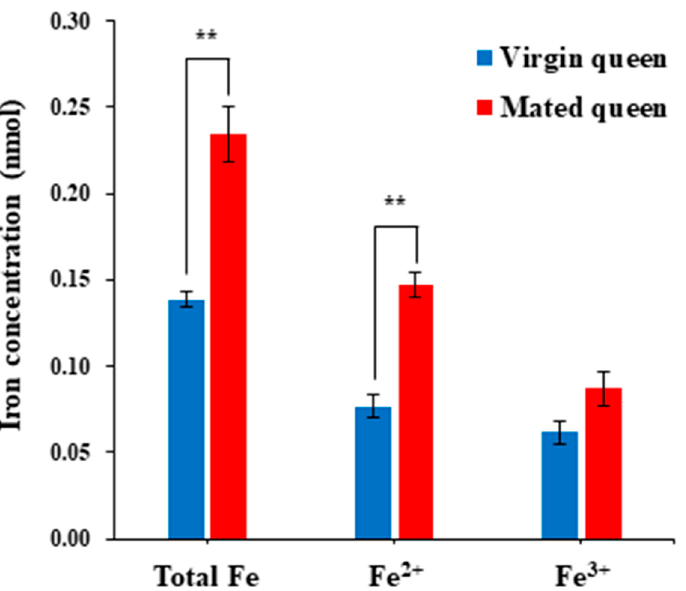
Figure 6. Iron concentrations in the spermathecal fluid of virgin and mated queens. The bars represent the mean ± SD values. Significant differences ( p < 0.01) are indicated with two asterisks.